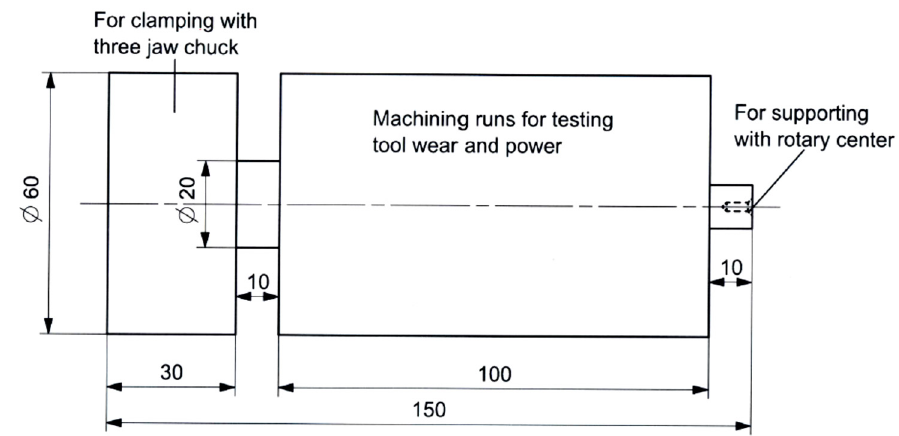
Figure 1. Cylindrical test piece for the turning tests (dimensions are in mm).